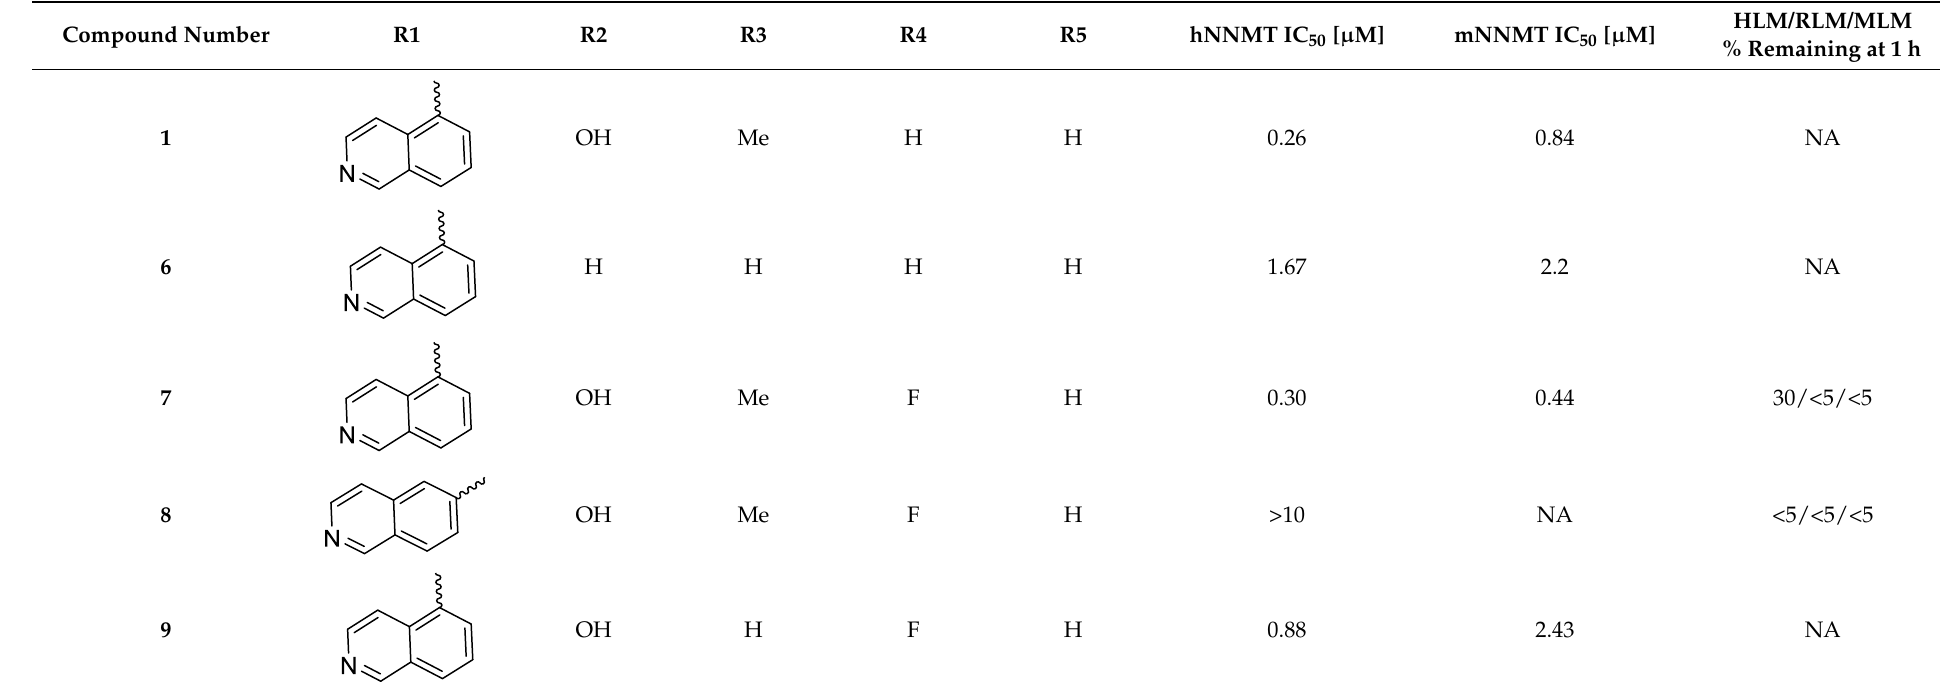
Figure 7. General formula of NNMT inhibitors described in Table 1 and Table 2. Table 1. Overview of NNMT inhibitors ( 1 )–( 13 ) and human/rat/mouse liver microsome (HLM/RLM/MLM) data Table 2. Overview of NNMT inhibitors ( 1 )–( 13 ) and human/rat/mouse liver microsome (HLM/RLM/MLM) data.